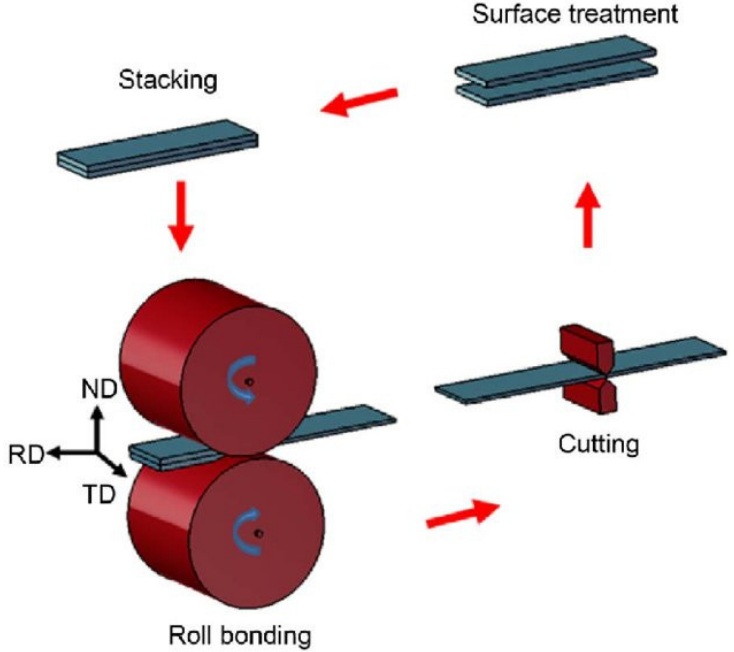
Figure 13. Schematic illustration of the accumulative roll-bonding (ARB) technique, adapted with permission from [109].